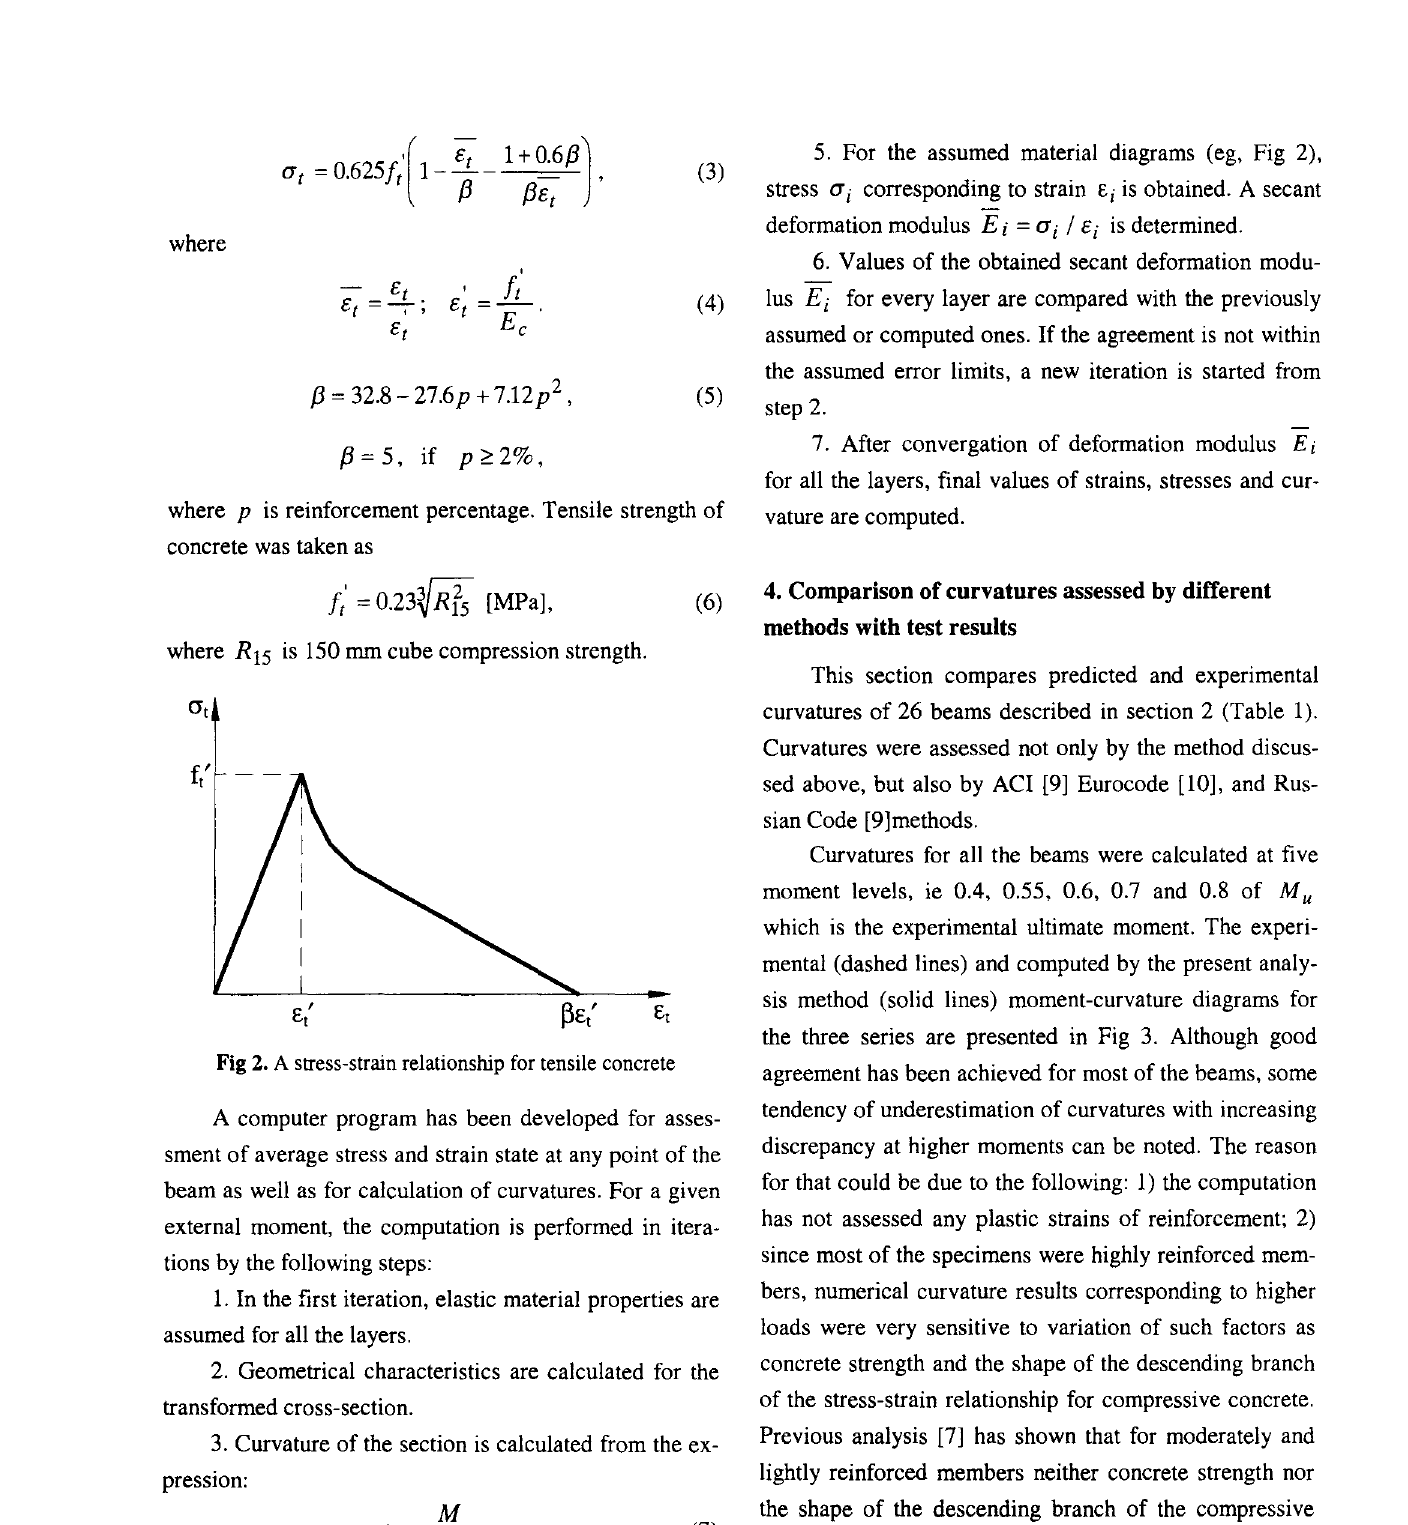
Fig 2. A stress-strain relationship for tensile